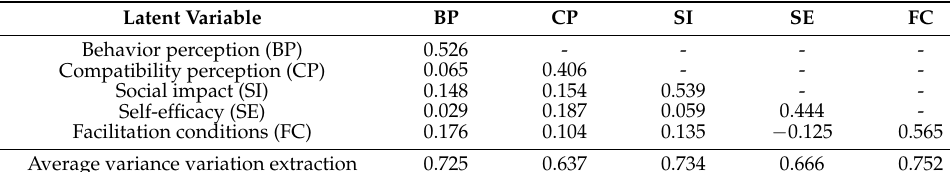
Table 6. Results of discrimination validity test of the